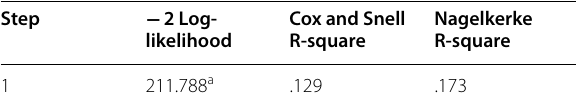
Table V. Model summary for attention to details culture